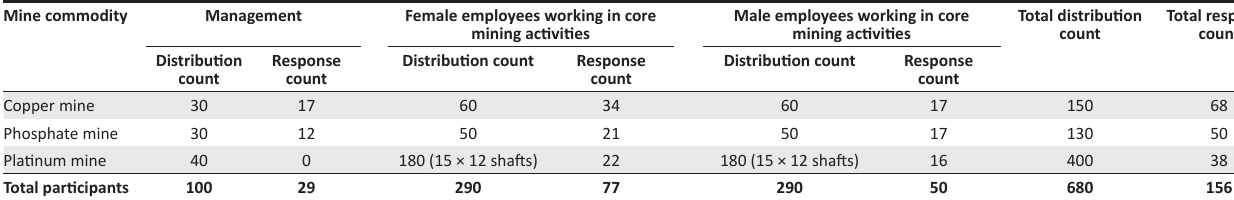
TABLE 1: Distribution and response count per